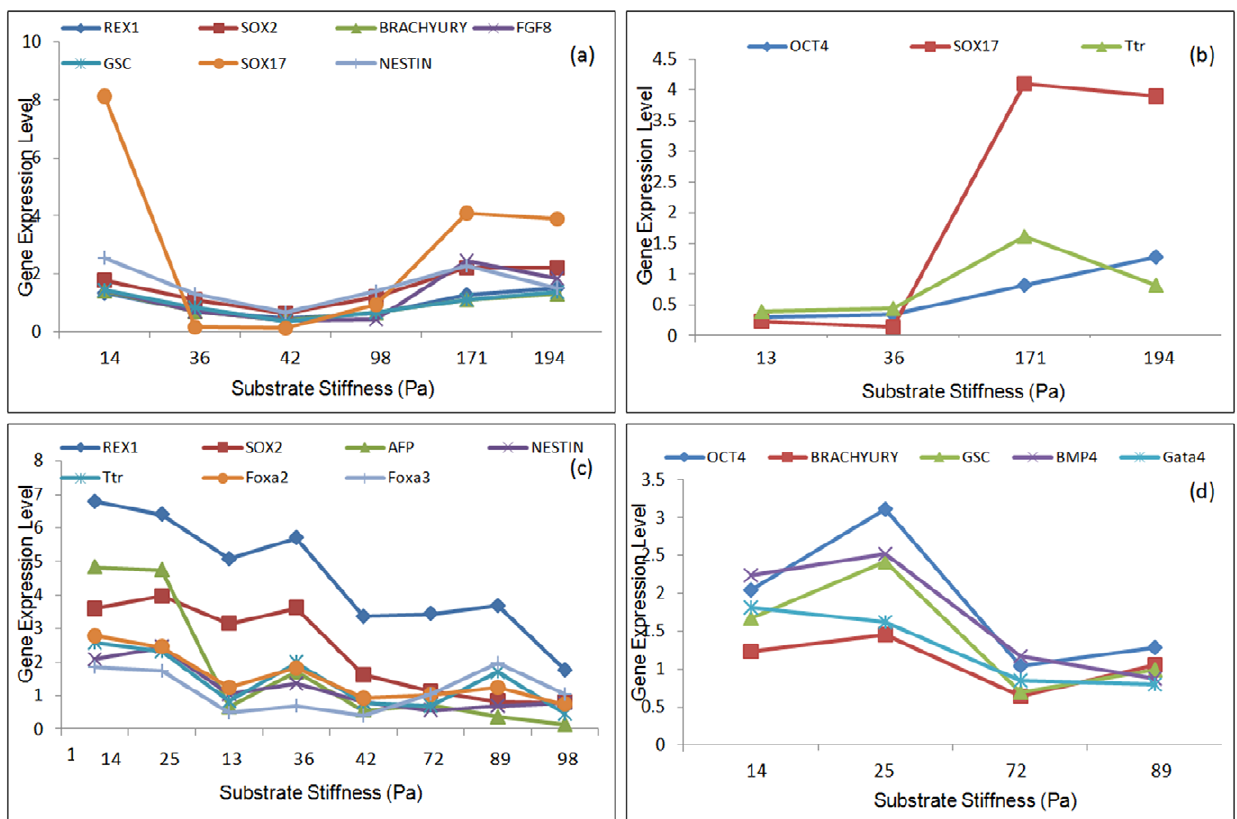
Figure 6. Optimal bi-clusters identified at mean value of experimental dataset. Solving equation (5) at mean value of the experimental data identifies the optimal bi-clusters for 2-dimensional culture (a, b) and 3 dimensional culture (c, d). The bi-clustering algorithm was solved sequentially by penalizing the previously identified bi-cluster in subsequent runs to avoid significant overlap. Single overlap was identified in the 2D dataset (Sox17) while no overlap was identified in the 3D dataset.